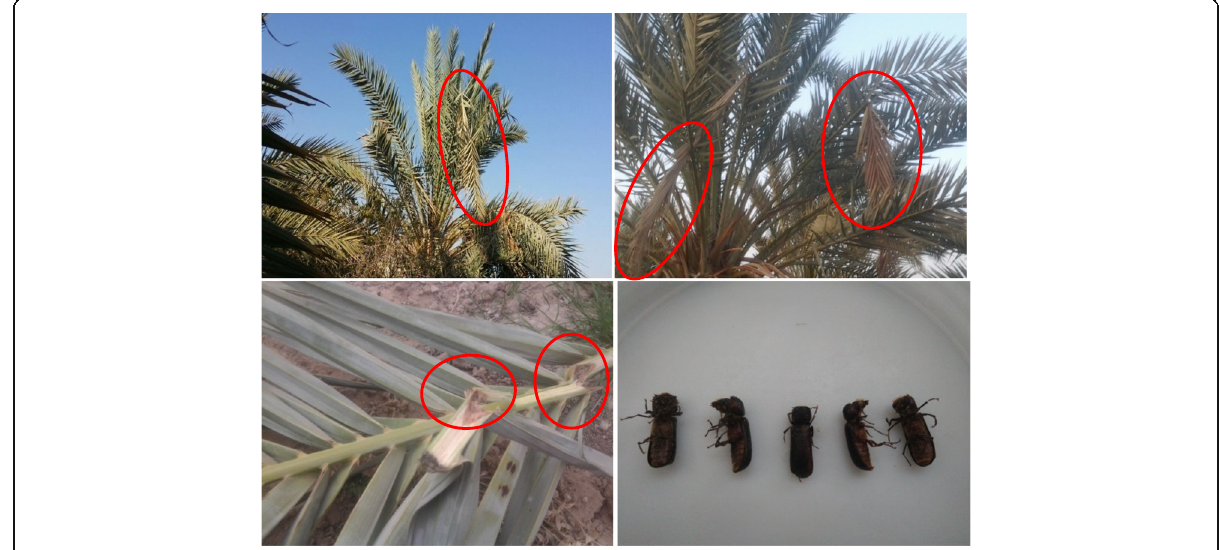
Fig. 1 Infestation symptoms and adult stage of the palm frond borer, Phonapate frontalis , at the date palm groves of Siwa Oasis (2015